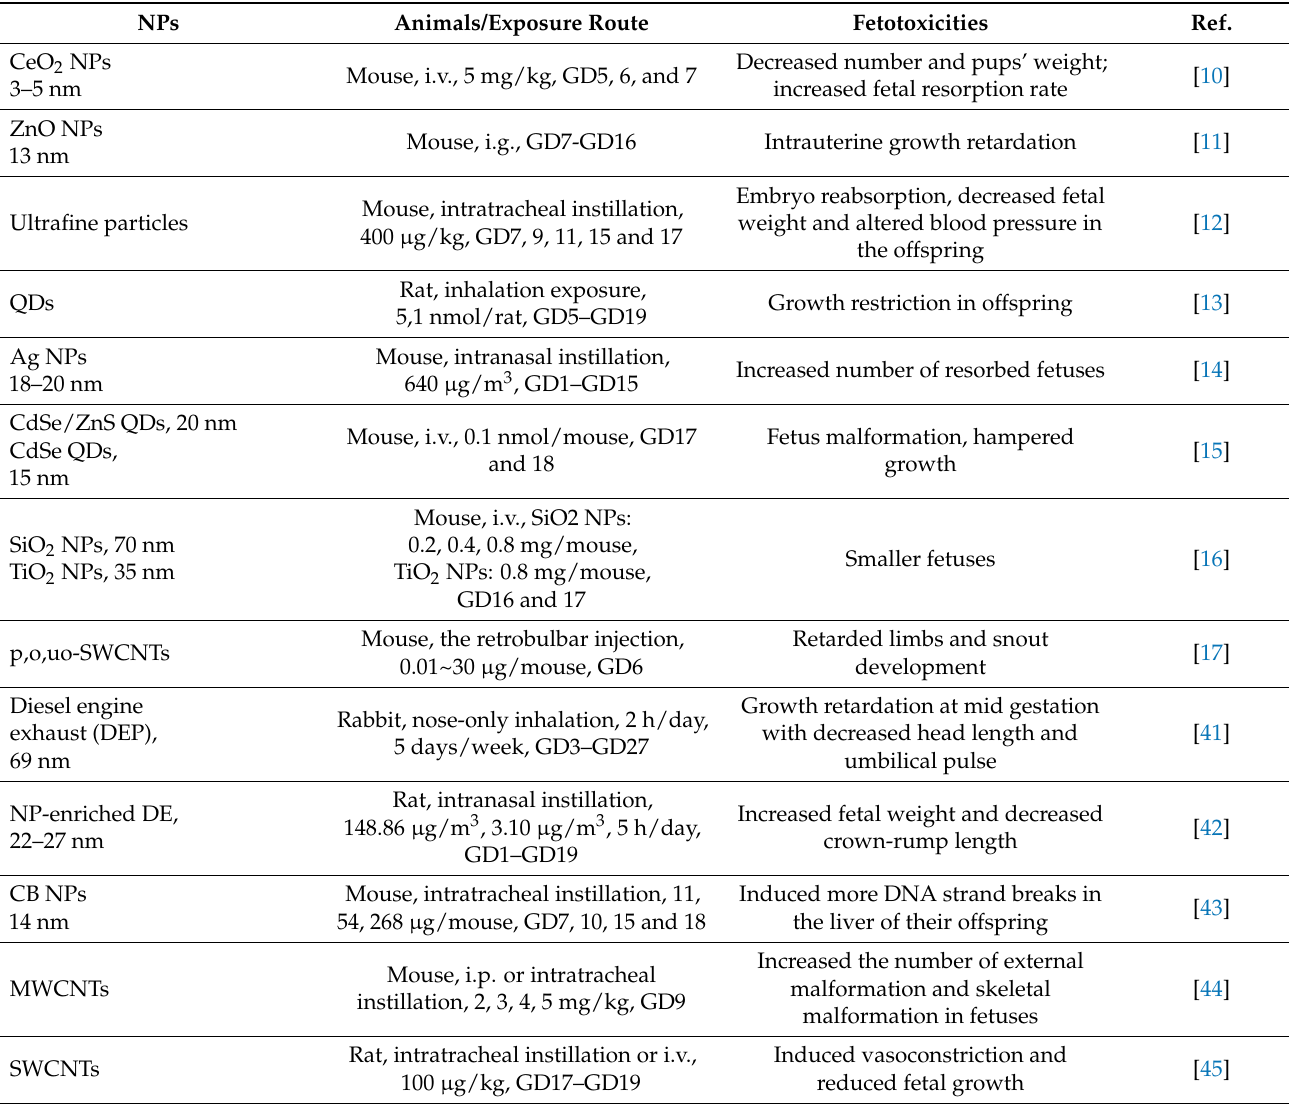
Table 1. Summary of gestational parameters induced following maternal exposure to nanoparticles (NPs). NPs Animals/Exposure Route Fetotoxicities